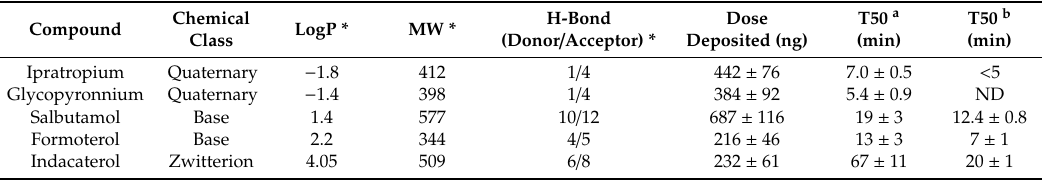
Properties, dose deposited and permeation rate through mucus layers of the bronchodilators